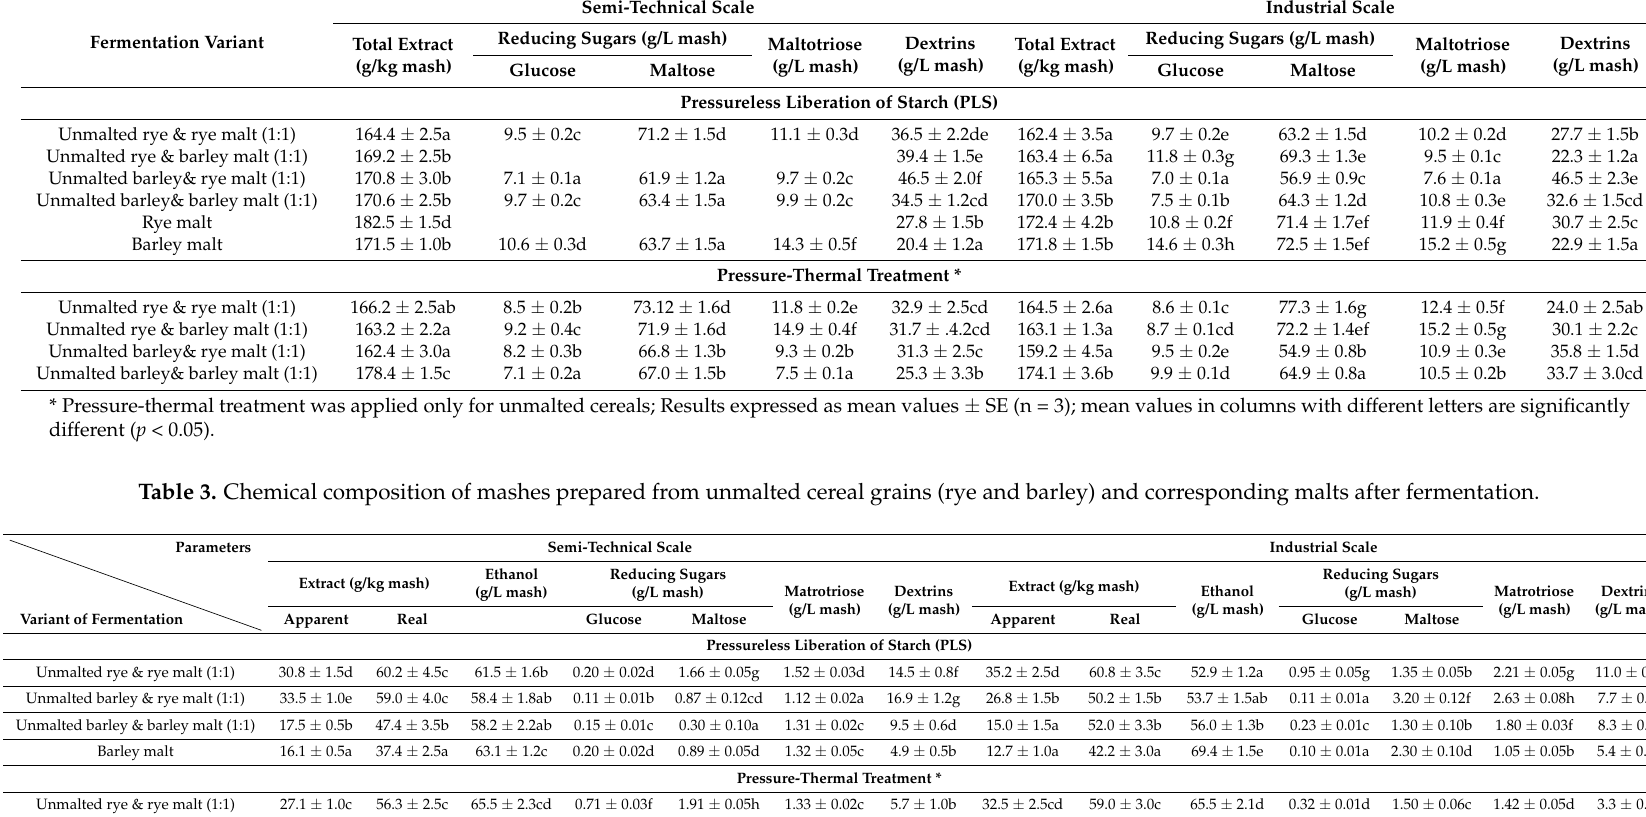
Table 2. Chemical composition of sweet mashes prepared from unmalted cereal grains (rye and barley) and corresponding malts.